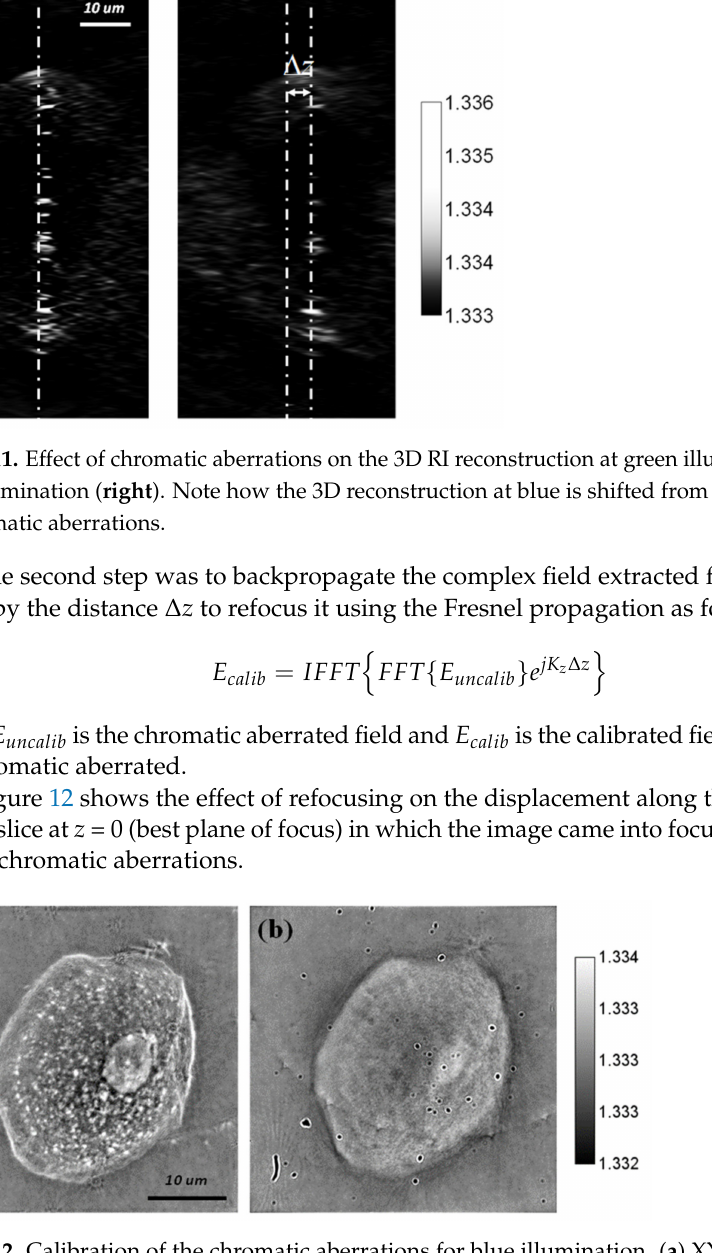
Figure 12. Calibration of the chromatic aberrations for blue illumination. ( a ) XY slice at z = 0 after calibration and ( b ) before